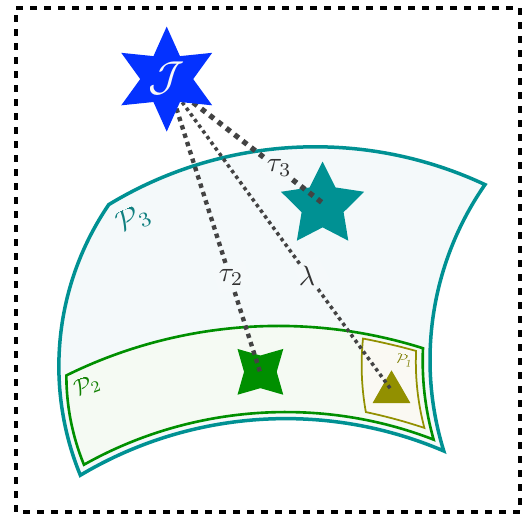
Figure 6 . An illustration of N -subjettiness values as the smallest distances, as measured by EMD, between the event and each of the N -particle manifolds . The jet angularities are the distances E P N to the 1-particle manifold . These observables form a set of \coordinates" for the P 1